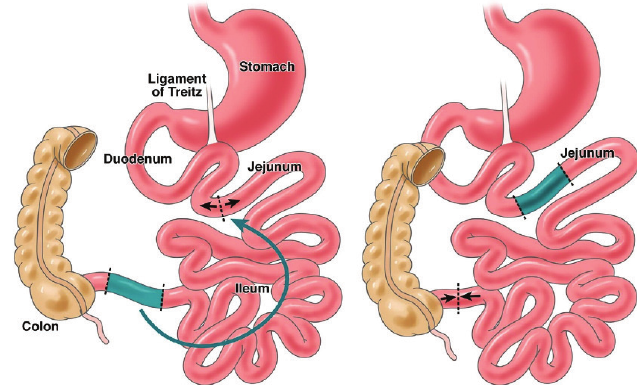
Figure 1 - Scheme of Ileal